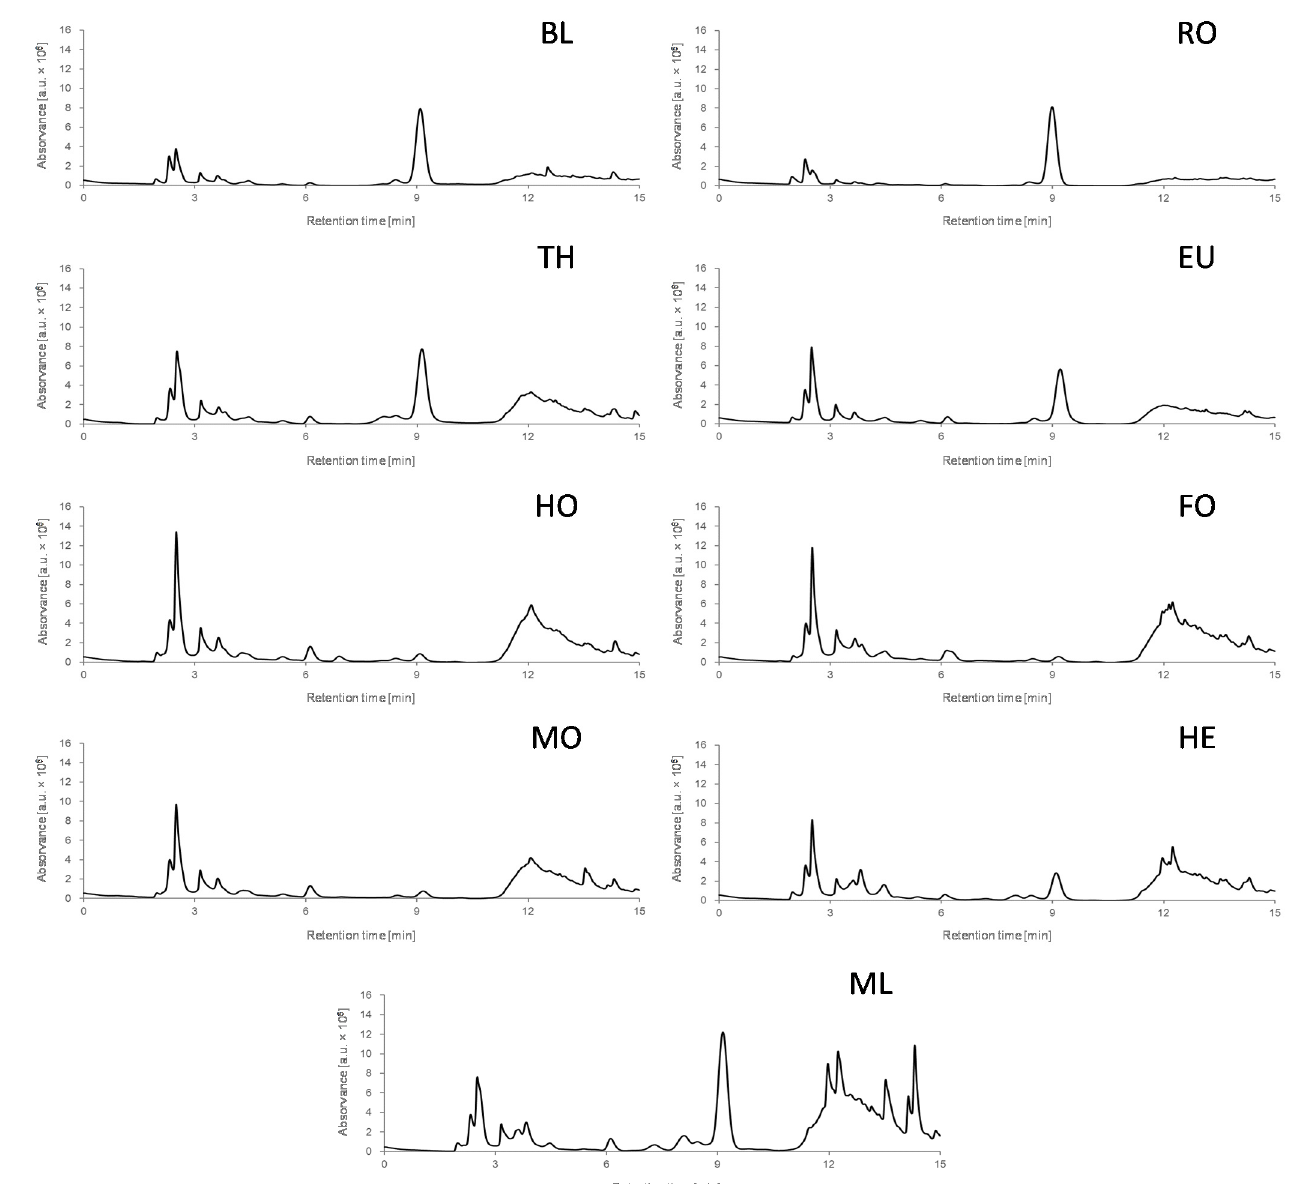
Figure 1. Non-targeted HPLC-UV chromatographic fingerprints at 280 nm for one selected blossom and honeydew honey sample of each botanical origin under study. BL: Orange/lemon blossom; EU: Eucalyptus; FO: Forest; HE: Heather; HO: Holm oak; MF: Multifloral; MO: Mountain; RO: Rosemary; TH: Thyme.